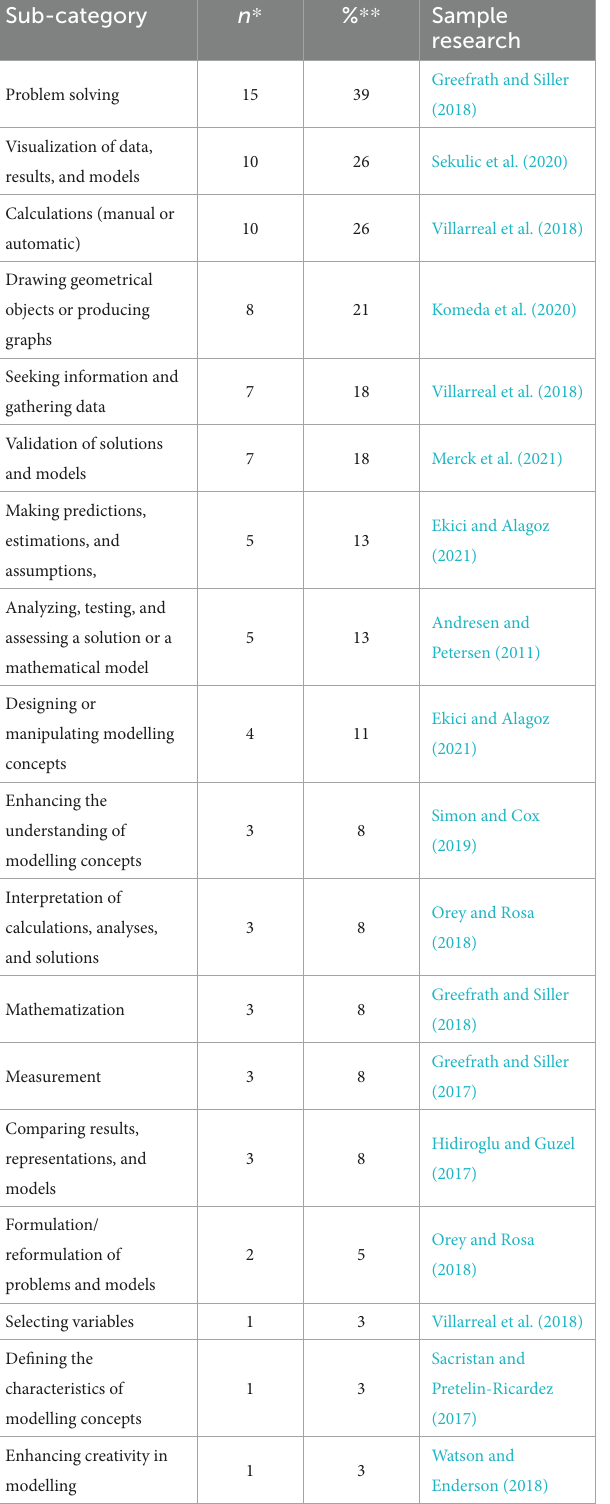
TABLE 5 Purposes of using digital technologies in modelling.